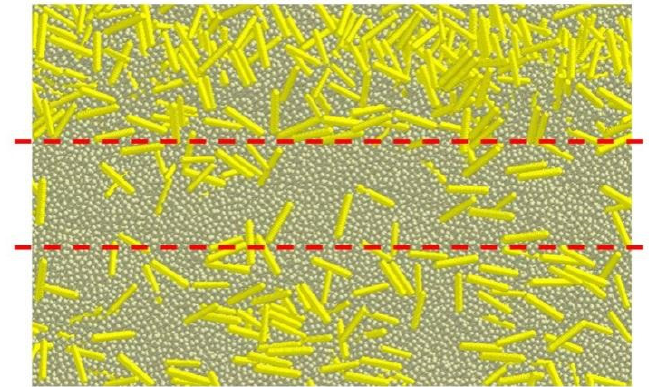
Figure 8. Test area of sowing strip straw cleaning effect. Note: The red dotted line area is the sowing strip after the operation of the SDARD.